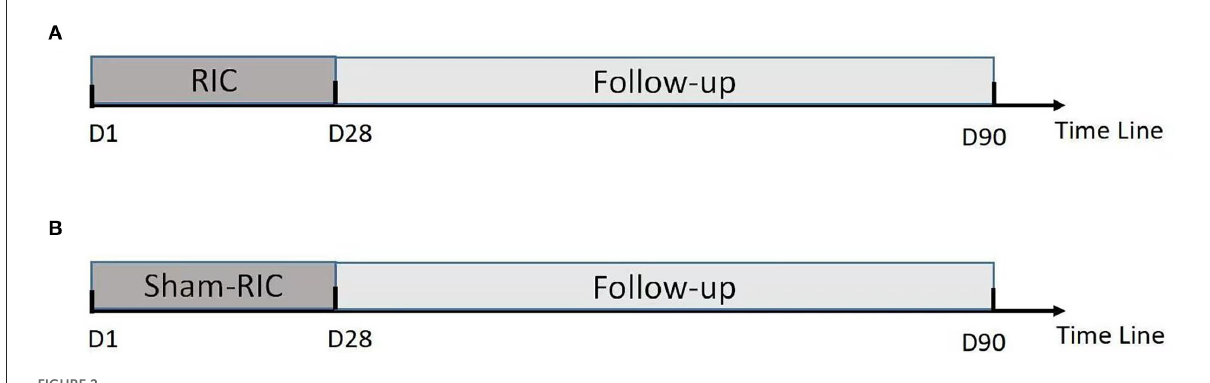
FIGURE2 Procedure timeline (A) RIC group; (B) Control group